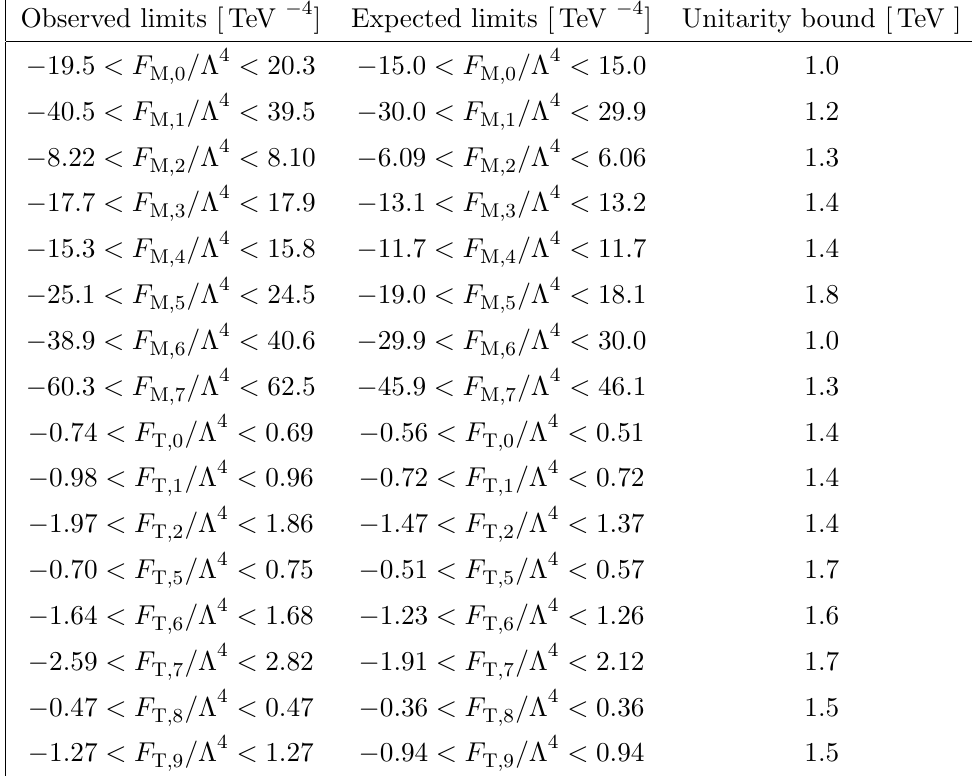
Table 4 . 95% CL exclusion limits in units of TeV (cid:0) 4 ; the unitarity bounds are also listed in units of